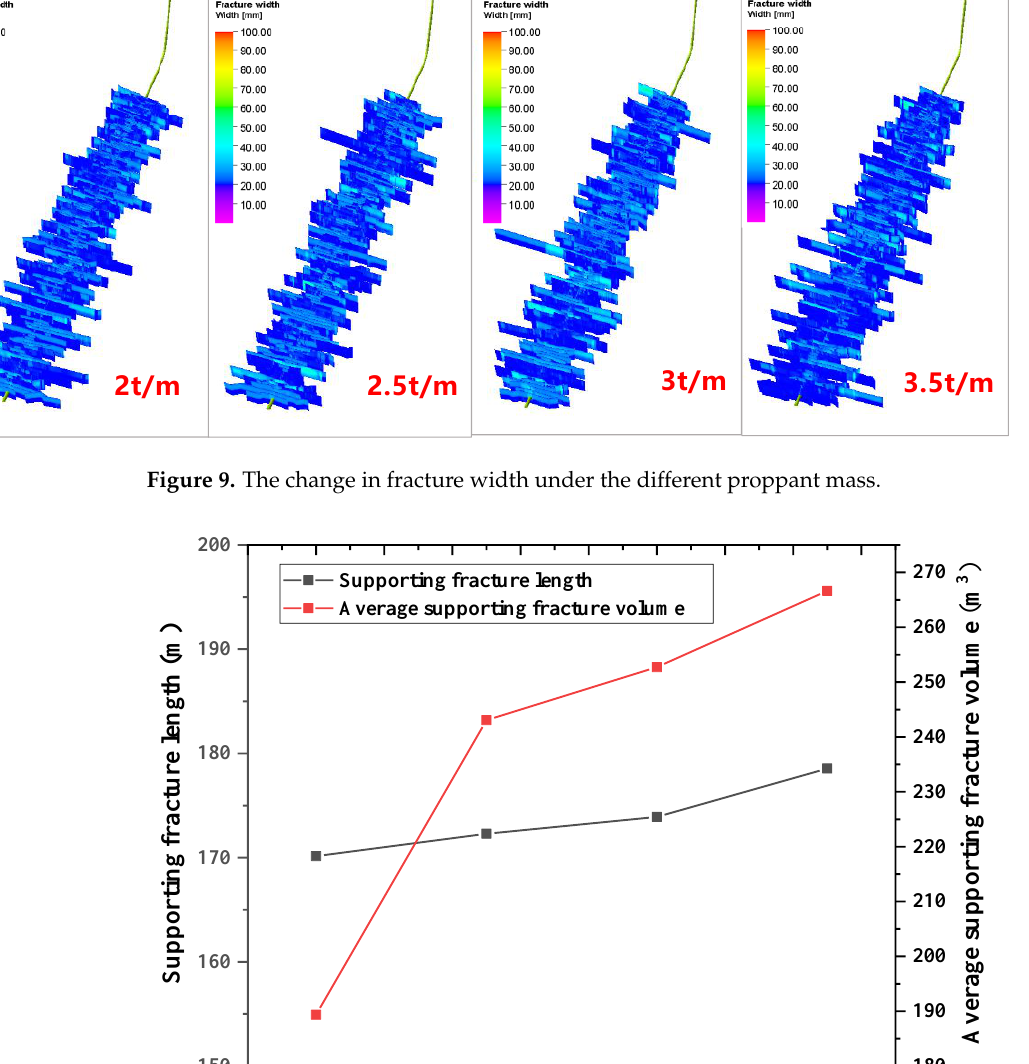
Figure 10. The change in supporting fracture length and volume under the different proppant mass.